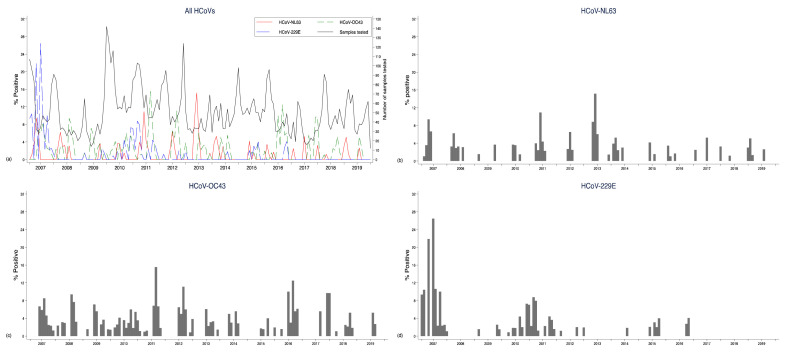
Monthly prevalence (%) pneumonia admissions at Kilifi County Hospital, Kilifi, Kenya 2007–2019 by HCoV type.The panel shows proportions for all HCoVs (
a), NL63 (
b), OC43 (
c) and 229E (
d).